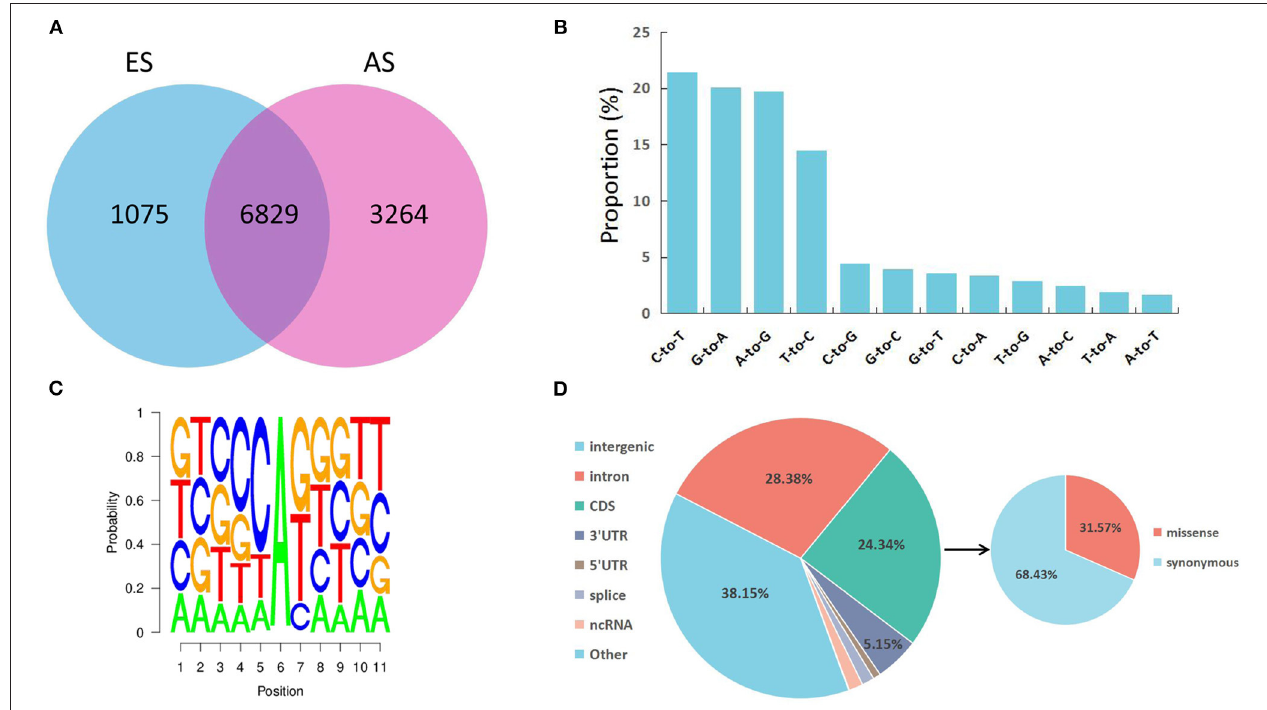
FIGURE 2 | Characteristics of the editome in the skeletal muscle. (A) Venn diagram showing the number of shared editing sites between AS and ES; (B) Proportion of 12 types of RNA editing; (C) Neighbor sequence preferences of A-to-G RNA editing; (D) Distribution of the identified RNA editing sites throughout the genome.